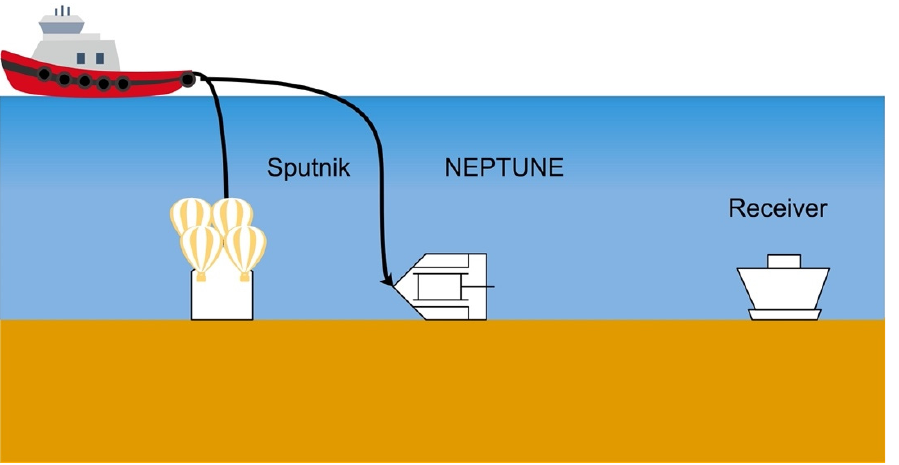
Figure 4. Stationary configurations of Sputnik (from [20] ) and NEPTUNE (from [46] ).